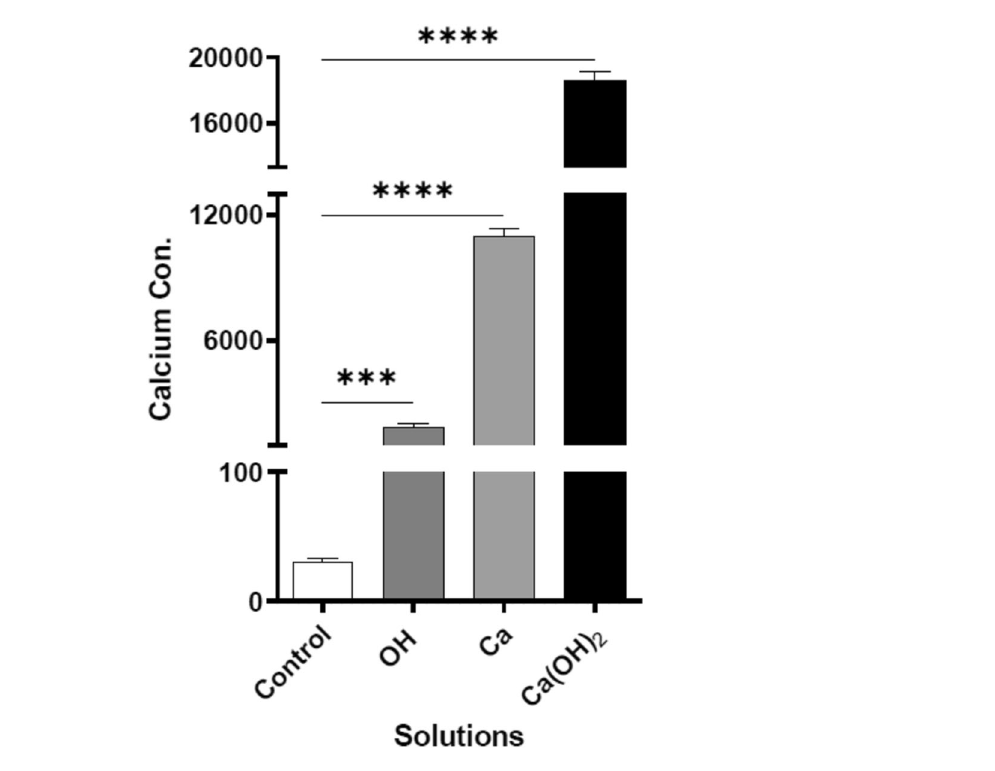
Figure 7. Ca 2+ concentration of biofilm in different groups ( P < 0.05). Significance: *, 0.05; **, 0.01; ***, 0.001; ****, 0.0001. Non-significant results are not